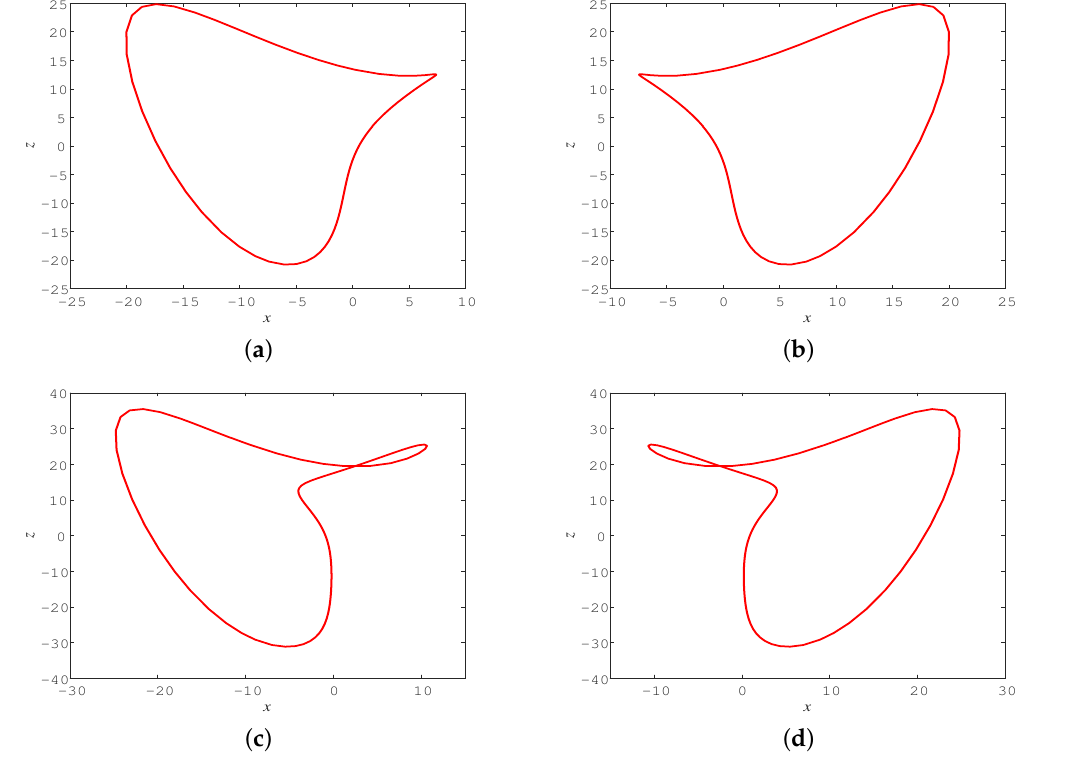
Figure 17. Four building blocks in system (1) for parameters ( a , b , c , k ) = ( 10,64,0,0 ) : ( a ) cycle 2; ( b ) cycle 3; ( c ) cycle 4; ( d ) cycle